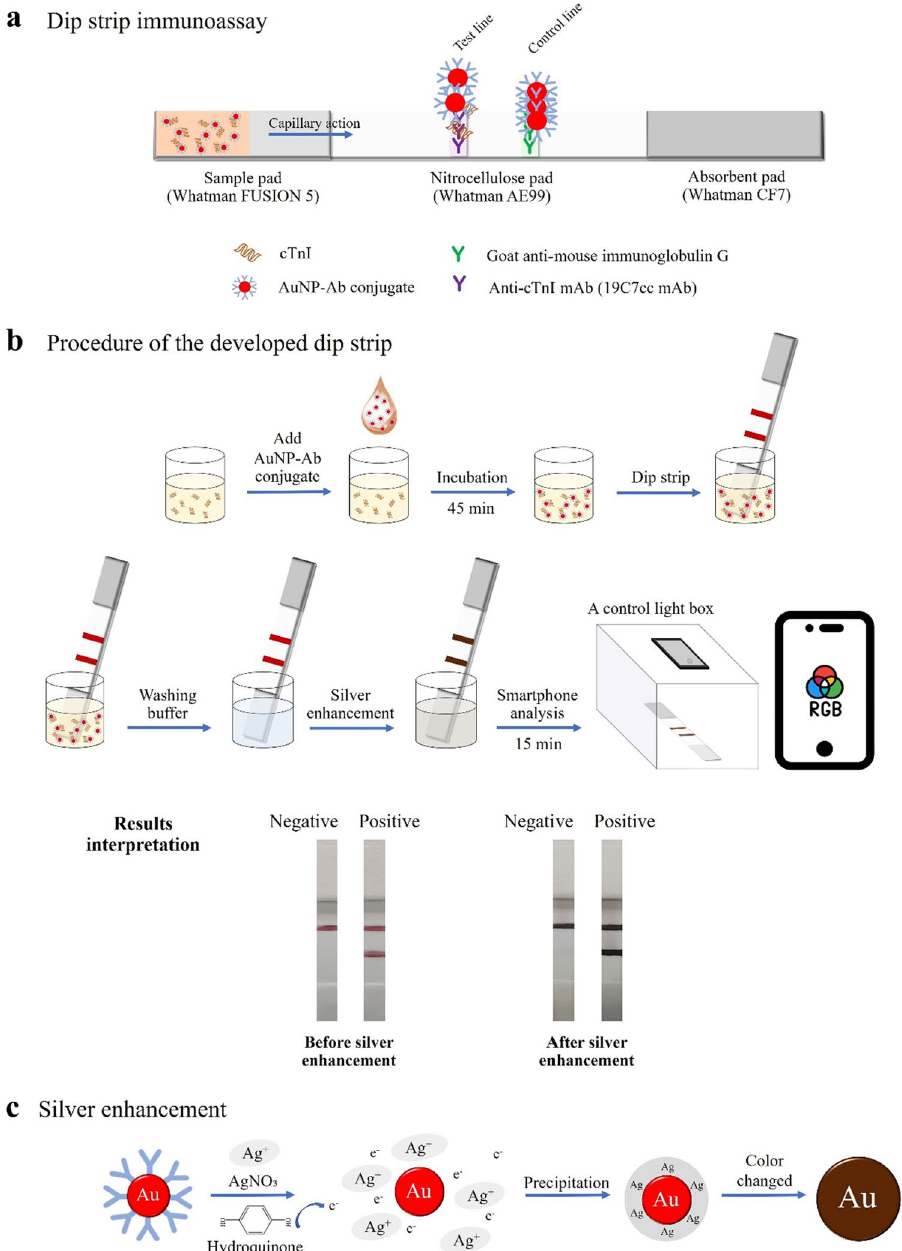
Figure 3. ( a ) Schematic illustration of the dip strip based on sandwich immunoassay. ( b ) Schematic diagram of the dip strip procedure. ( c ) Schematic of silver enhancement reaction showing the change of AuNP